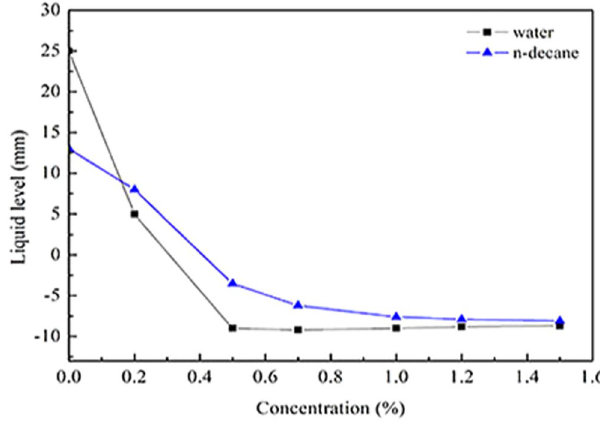
Figure 9. The height of the water and n-decane suction capillary.